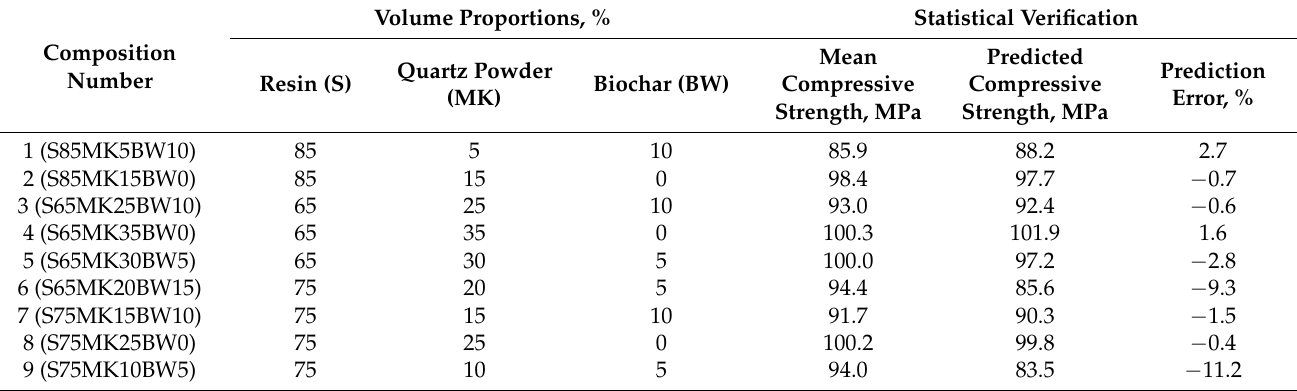
Table 5. Result of the compressive strength—measured and predicted.